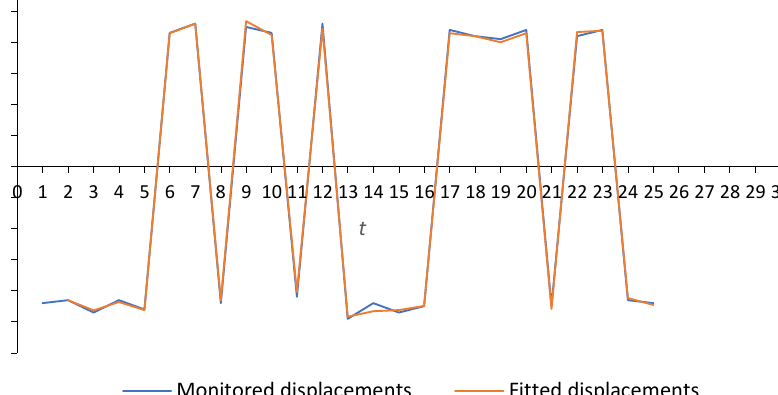
Figure 12. Original and fitted displacements of marker M4 along x -axis. The mean absolute percentage error (MAPE) is 1.88%, and according to Table 1, the fitting model of the displacement of marker M4 along the x -axis belongs to a highly